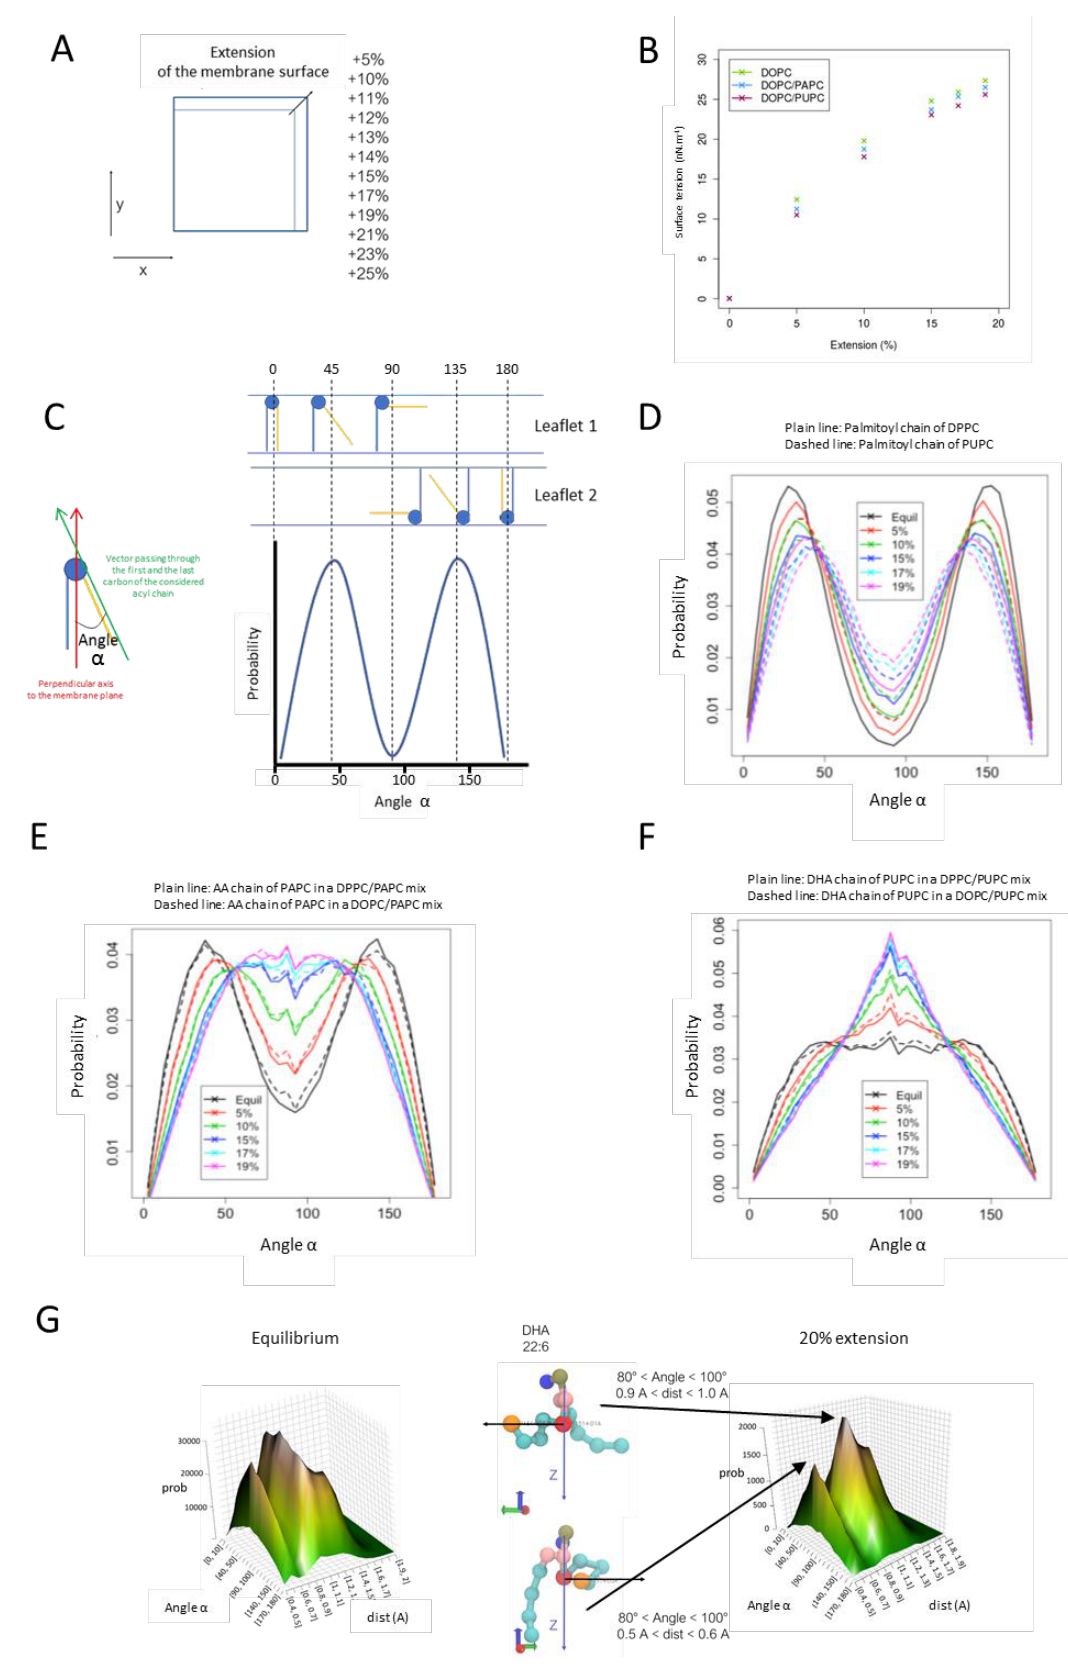
Figure 8. Molecular dynamics simulations of simple membranes composed of PC bearing various fatty acid compositions in response to surface expansion. ( A ) To mimic surface expansion using molecular dynamics simulations, the values of